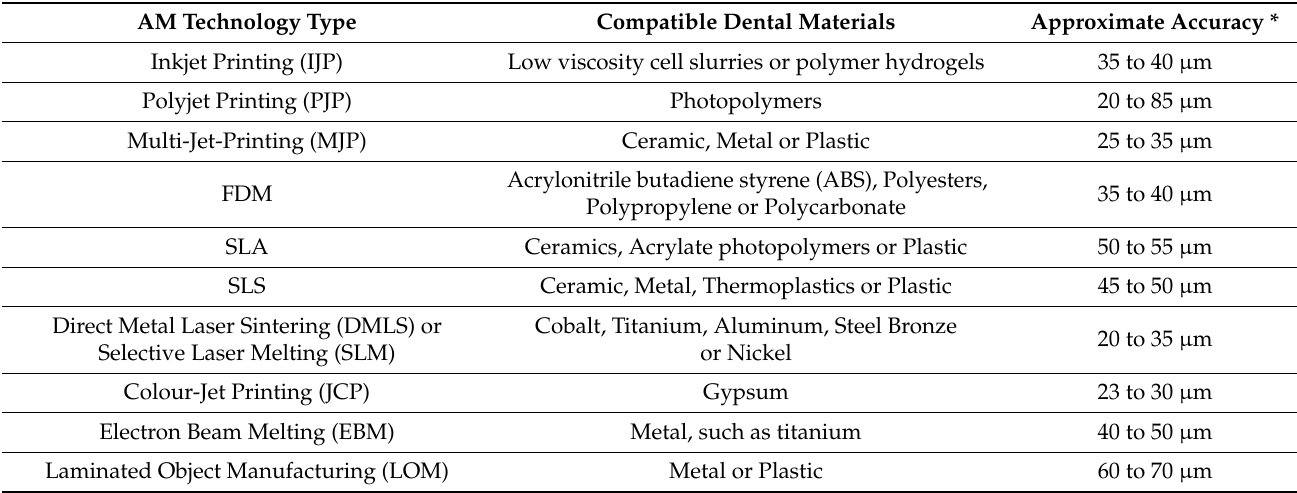
Table 2. A list of additive manufacturing (AM) technologies based on the biomaterials utilized in the field of dentistry